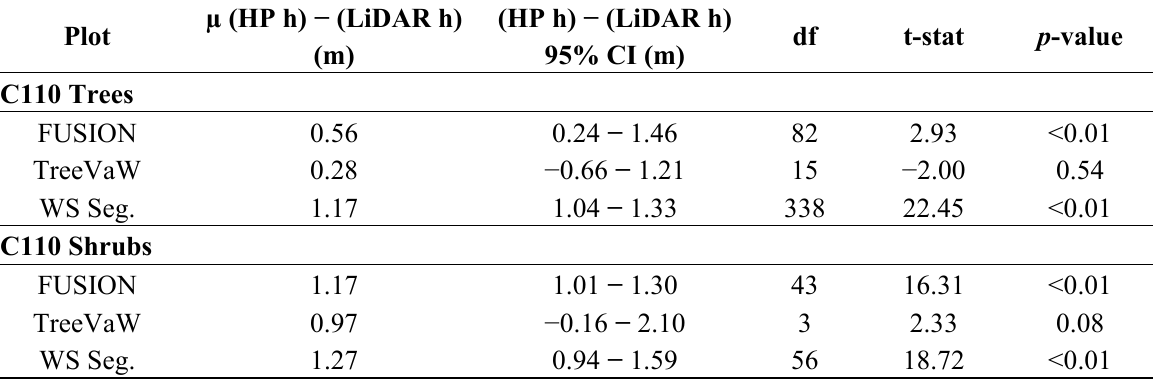
Table 11. Statistical comparison of LiDAR-derived tree heights (h) to height pole measured (HP) tree heights in one clearcut